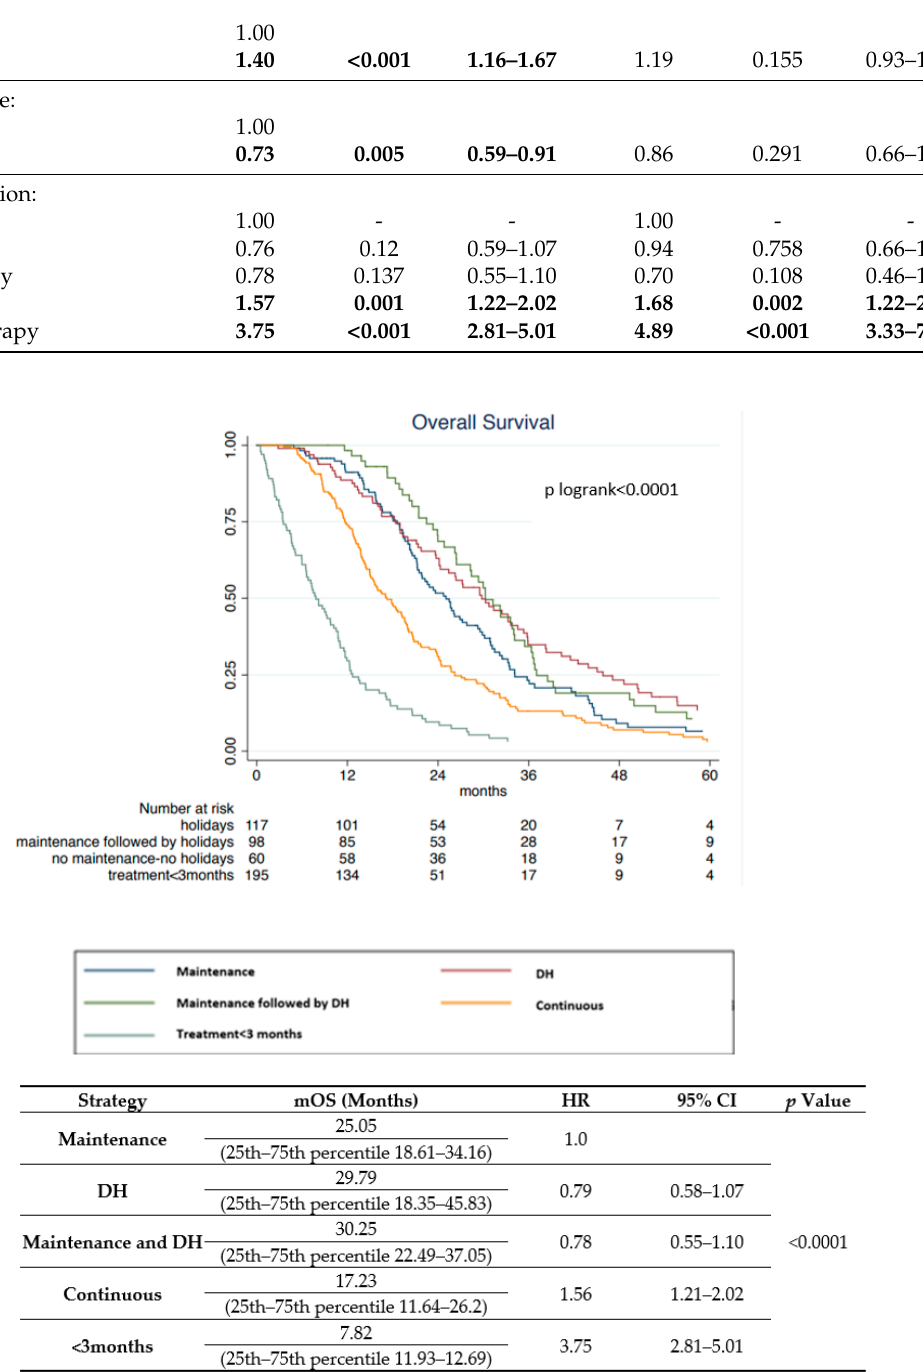
Figure 1. Kaplan–Meier survival curves according to strategy.